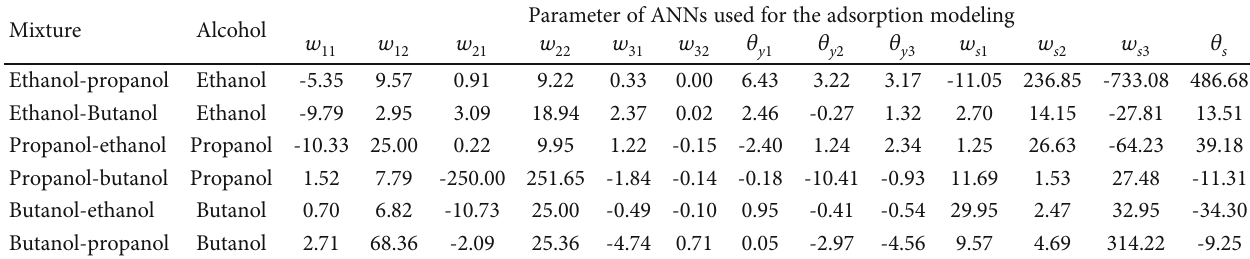
Table 5: Parameters of ANN models to predict the adsorption of bioalcohols on bone char.